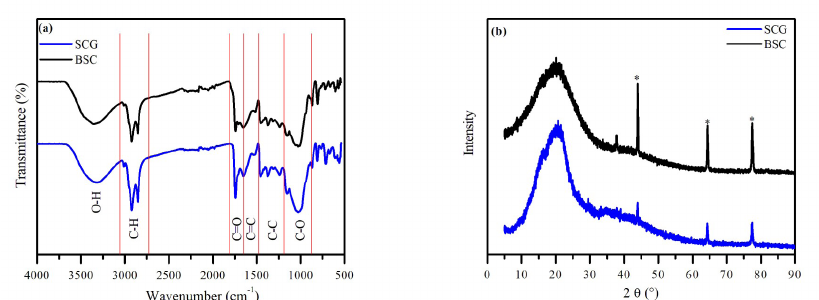
Figure 1. FTIR spectra from SCG and BSC (a) and XRD from SCG and BSC (b). * = peak referring to the aluminum sample holder 37